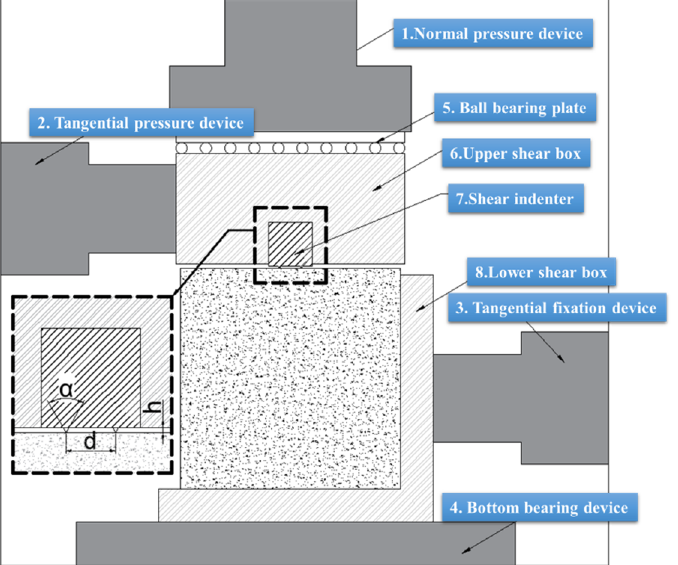
Figure 2. Diagram of the test rig. (1.) Normal pressure device (2.) Tangential pressure device (3.) Tangential fixation device (4.) Bottom bearing device (5.) Ball bearing plate (6.) Upper shear box (7.) Shear indenter (8.) Lower shear box.